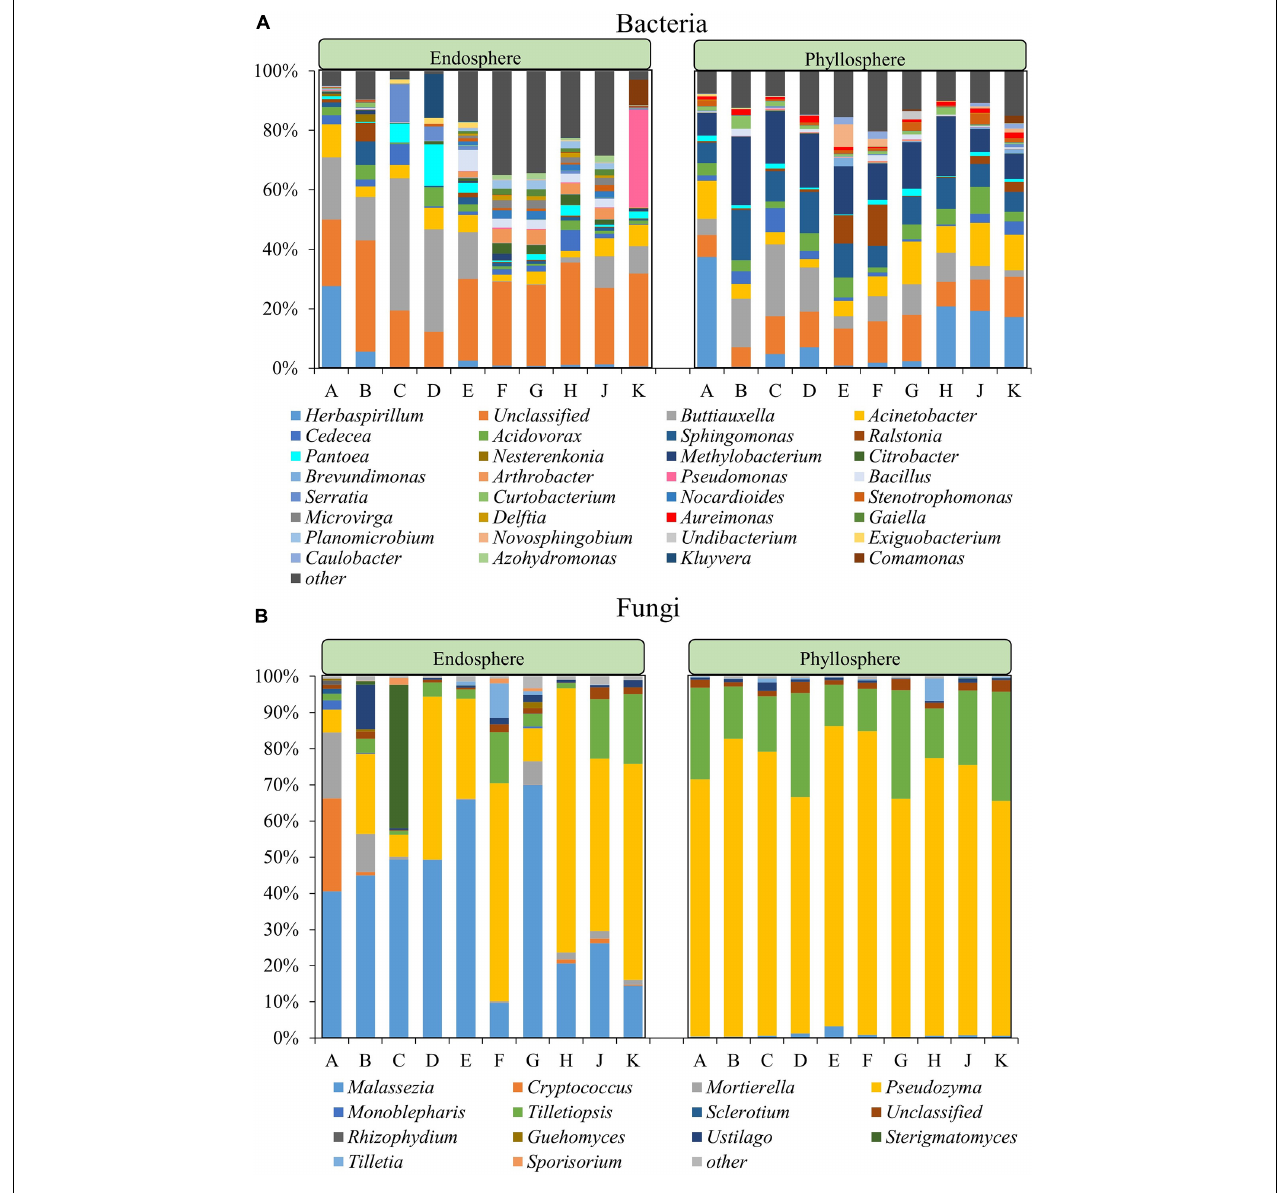
FIGURE 2 | Community composition within the bacterial (A) and fungal (B) community at genus level. For both communities the phyllosphere and the endosphere are separately shown. The fraction labeled with “other” represents the sum of all microorganisms with a relative abundance < 2% in all community types.